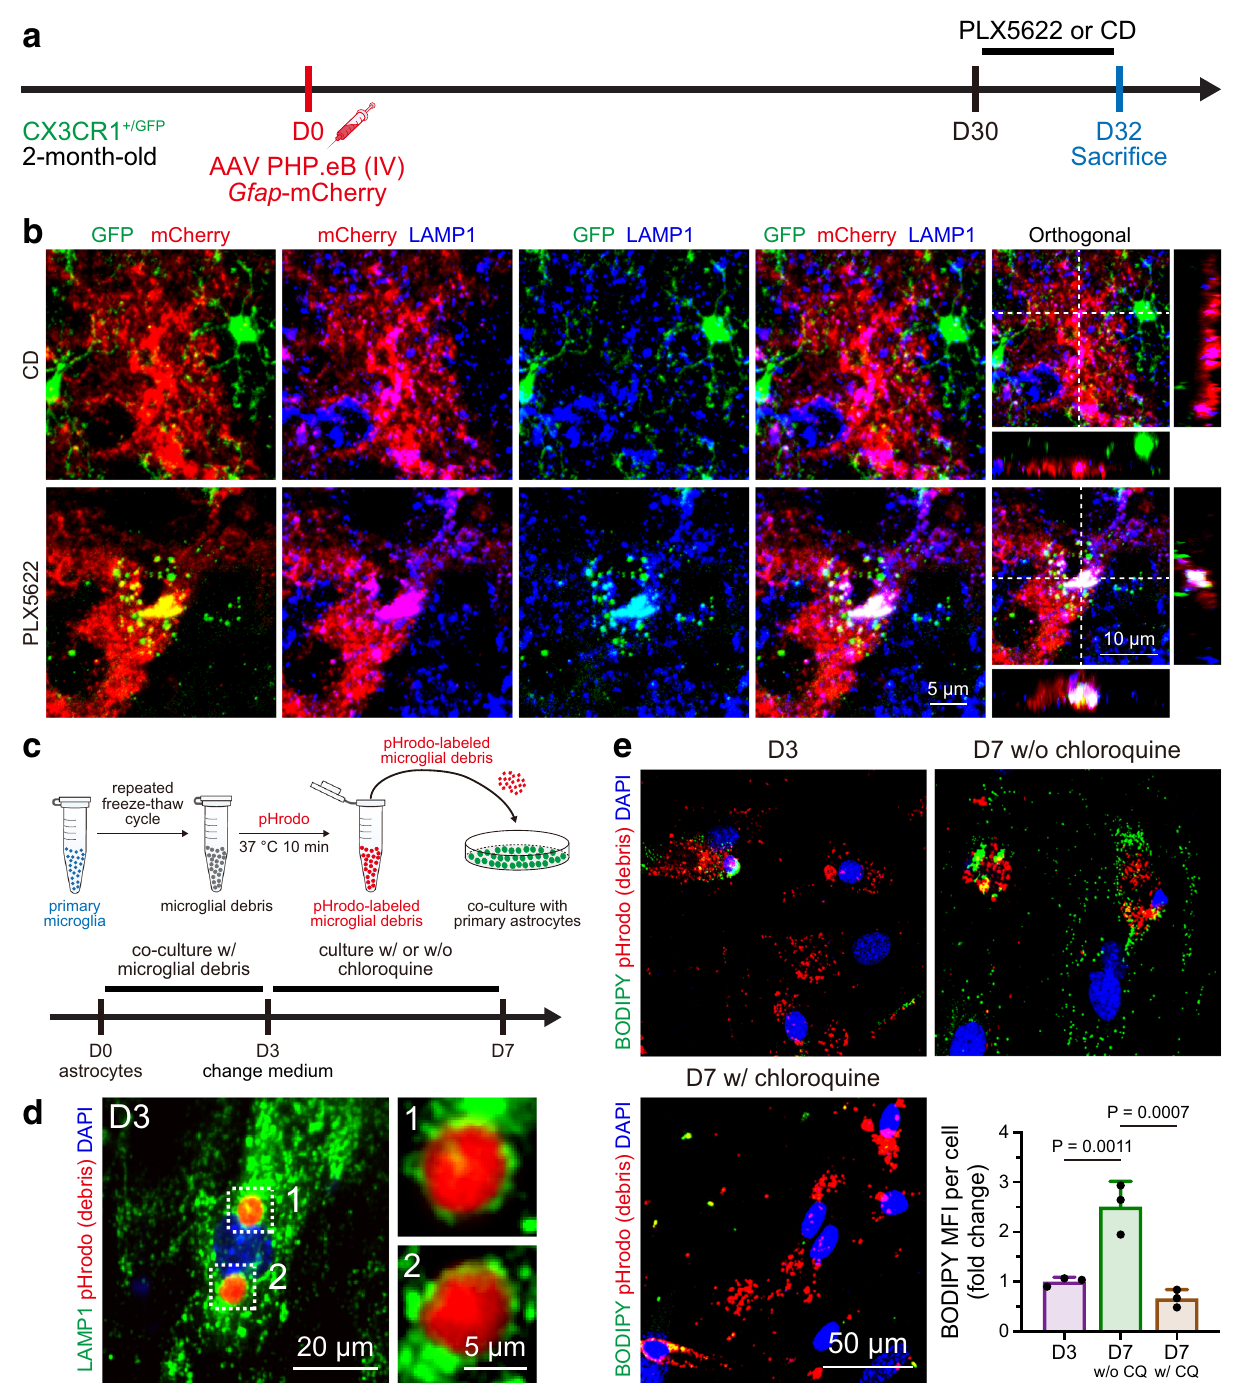
Fig. 9 | Microglial debris-containing LAPosomes are fused with acidic lyso- somesfordegradationinvivoandinvitro.a Scheme of the in vivo examination of astrocytic engulfment involving AAV PHP.eB-based astrocyte labeling and microglial depletion. b Intra-astrocytic microglial debris colocalized with LAMP1 in vivo. Each experiment was independently repeated from 7 mice with similar results. c Schemes of the in vitro astrocytic engulfment assay using pHrodo-labeled microglial debris. d pHrodo-labeled microglial debris loca- lized with LAMP1 in in vitro cultured astrocytes. Each experiment was